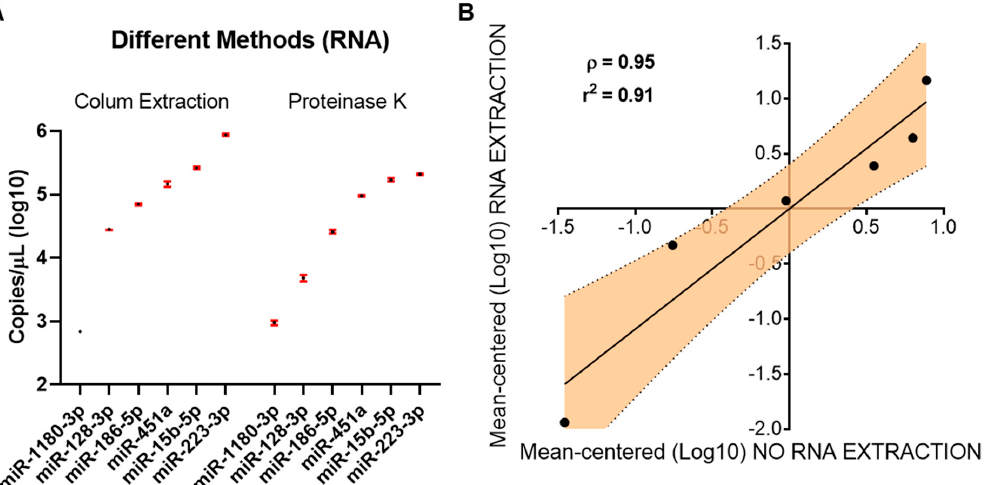
Figure 3. Comparison of column-based RNA extraction (Colum Extraction) or no-extraction (Proteinase K) protocols. ( A ) Normalized copies of column-based RNA extraction and no-extraction protocols on starting volume (50 µL and 200 µL, respectively). The level of each miRNA was calculated as Log10 of copy number/µL. Black dots represent the mean value, while error bars (red) represent the 95% confidence interval. ( B ) Correlation analysis between plasma miRNA expression after either column-based RNA extraction and no-extraction protocols. The level of each miRNA was calculated as Log10 of copy number/µL and reported as mean-centered.